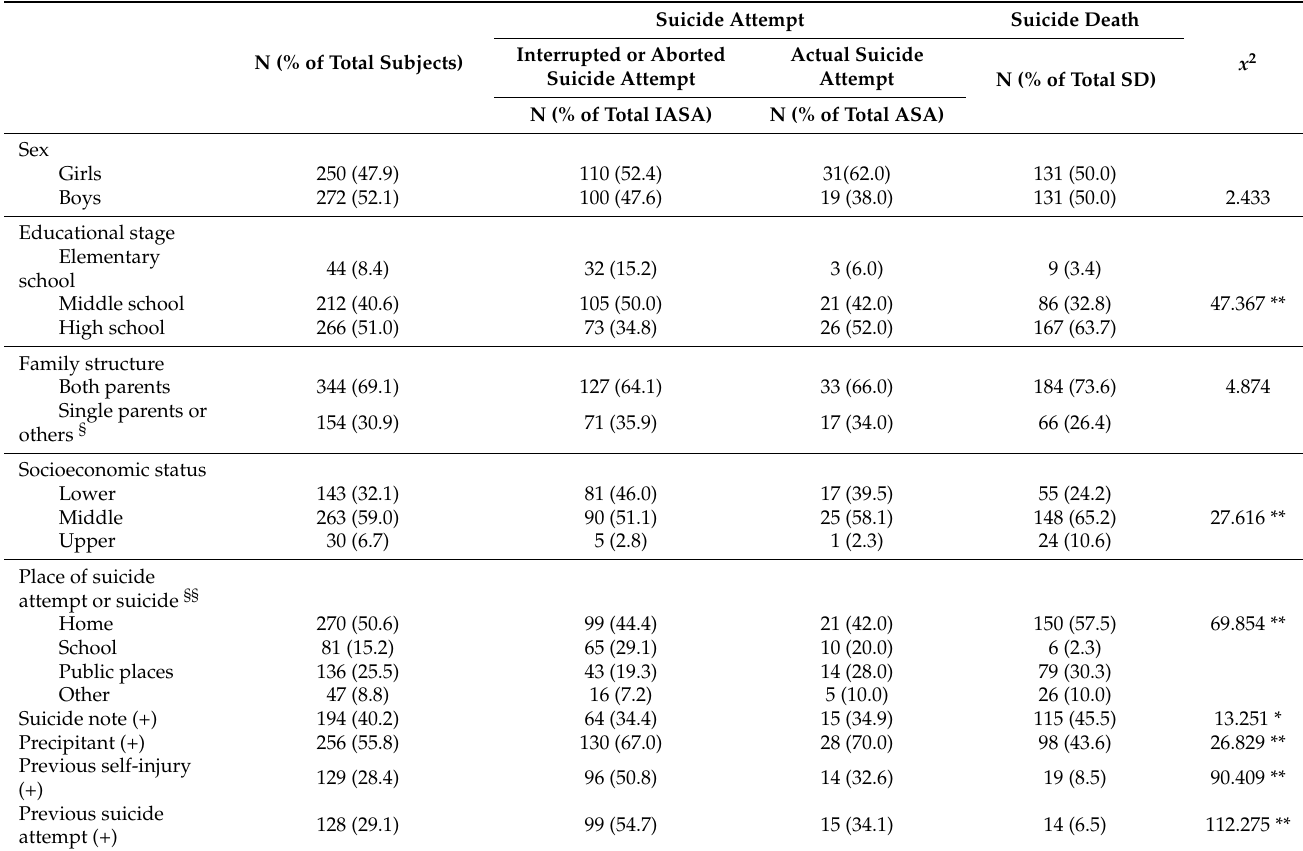
Table 1. Comparison of sociodemographic and suicide-related